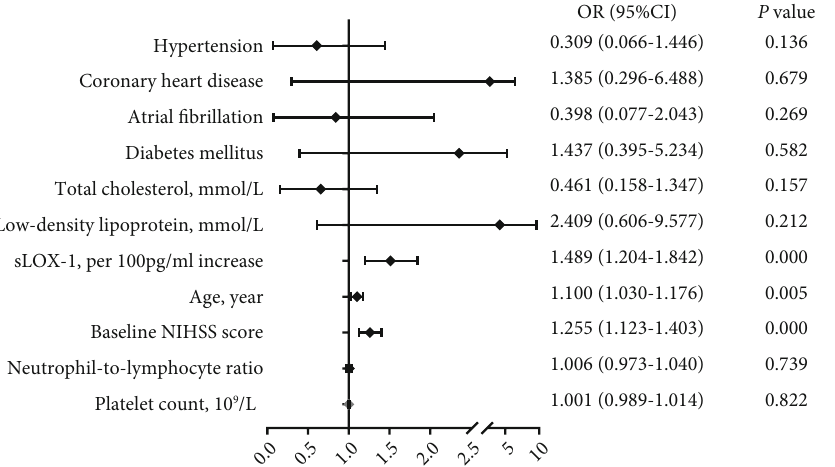
Figure 5: Forest plot shows the risk of the primary outcome after AIS. After adjusting for age, admission NIHSS score, neutrophil-to- lymphocyte ratio, diabetes mellitus, atrial fi brillation, coronary heart disease, hypertension, platelet count, low-density lipoprotein, and total cholesterol, binominal multivariate logistic analysis showed that sLOX-1 level was an independent predictor for unfavorable outcome in patients with recurrent ischemic stroke.